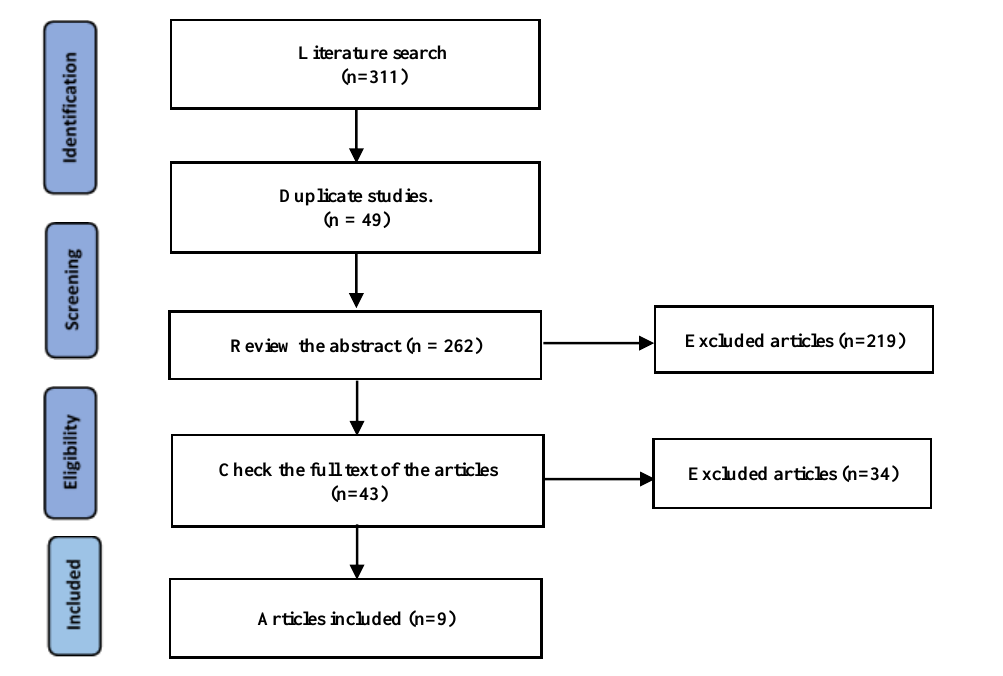
Fig. 1. PRISMA flowcharts.